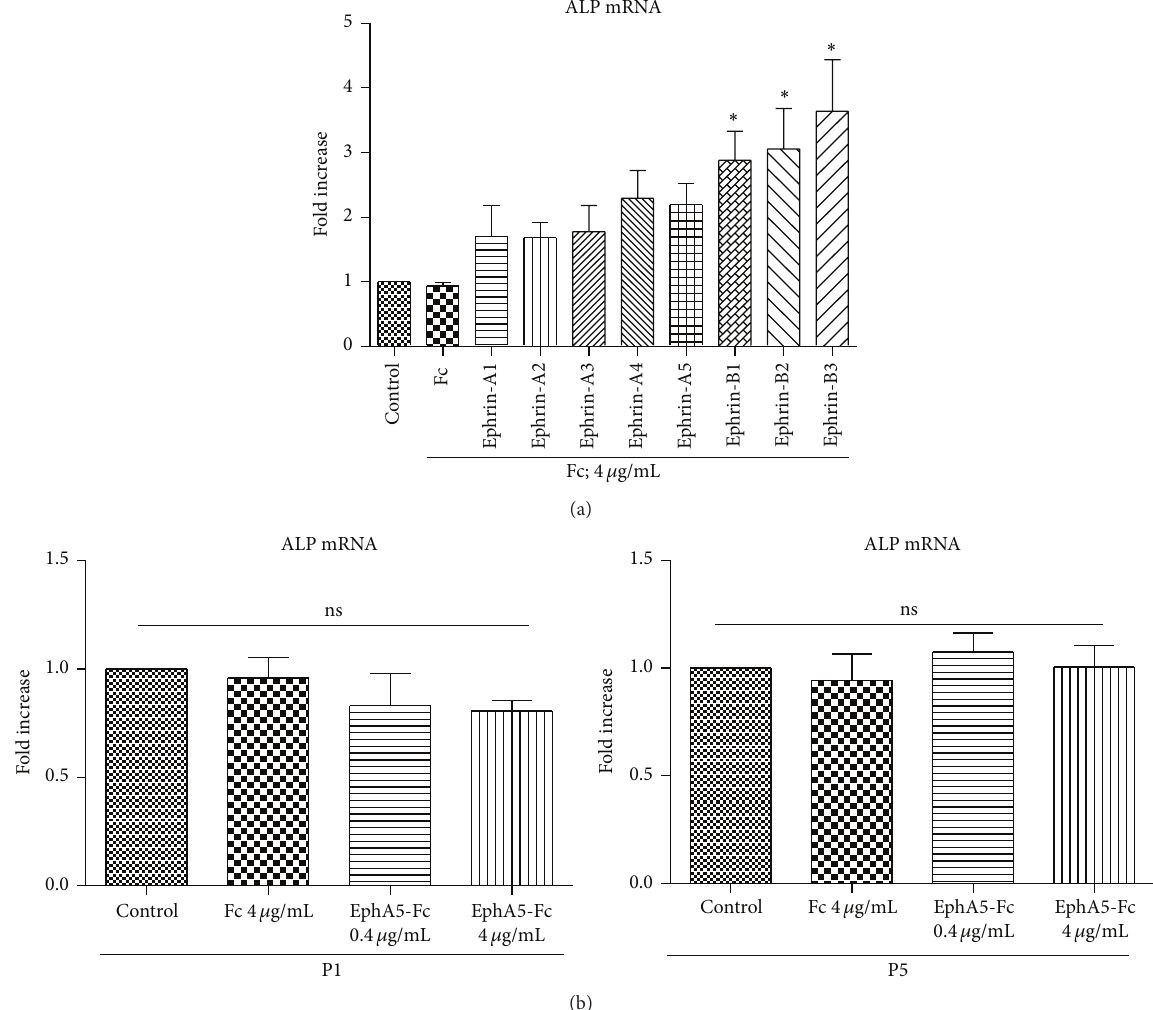
Figure 3: hBMSCs treated with EphA5-Fc express ALP mRNA at levels similar to those of nontreated hBMSCs. (a) hBMSCs at P5 were left untreated (control) or treated for 7 days with 4 𝜇 g/mL Fc or ephrin-Fc. Quantitative analysis of ALP mRNA expression ( 𝑛 = 4 ). The fold change of gene expression was normalized against the expression in cell cultures without Fc treatment. (b) hBMSCs at P1 (left) or P5 (right) were left untreated (control) or treated for 7 days with 0 or 4 𝜇 g/mL Fc and EphA5-Fc. Quantitative analysis of ALP mRNA expression ( 𝑛 = 4 ). The fold change of gene expression was normalized against the expression in cell cultures without Fc treatment. Images of wells after ALP staining